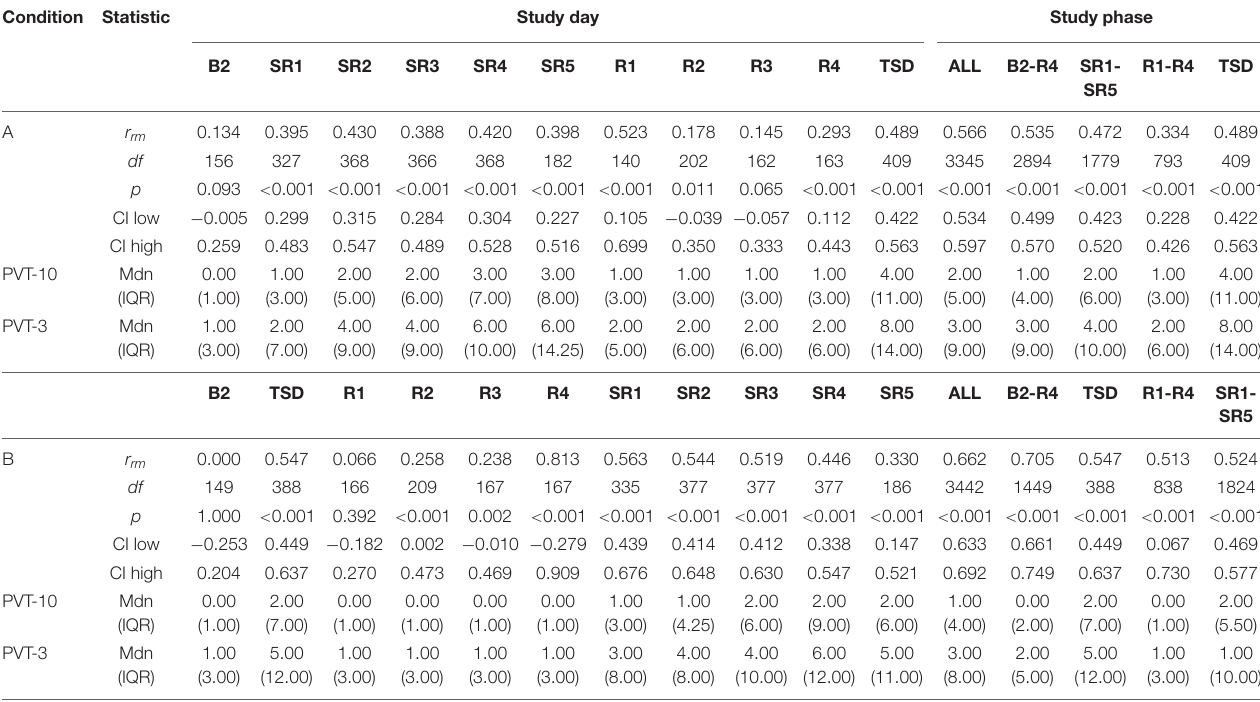
TABLE 1 | PVT-10 and PVT-3 lapses rmcorr results by day and by study phase. Condition Statistic Study day Study phase